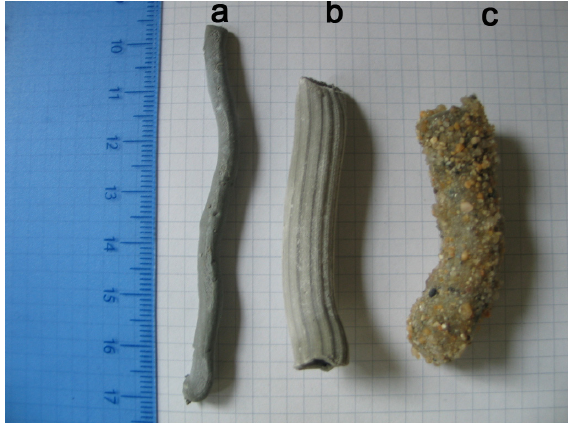
Figure 2. The two typologies of hollow tubes achieved by the extrusion of the cement paste: ( a ) bucatino shape; ( b ) maccherone shape; ( c ) maccherone shape after the application of coatings and sand on the